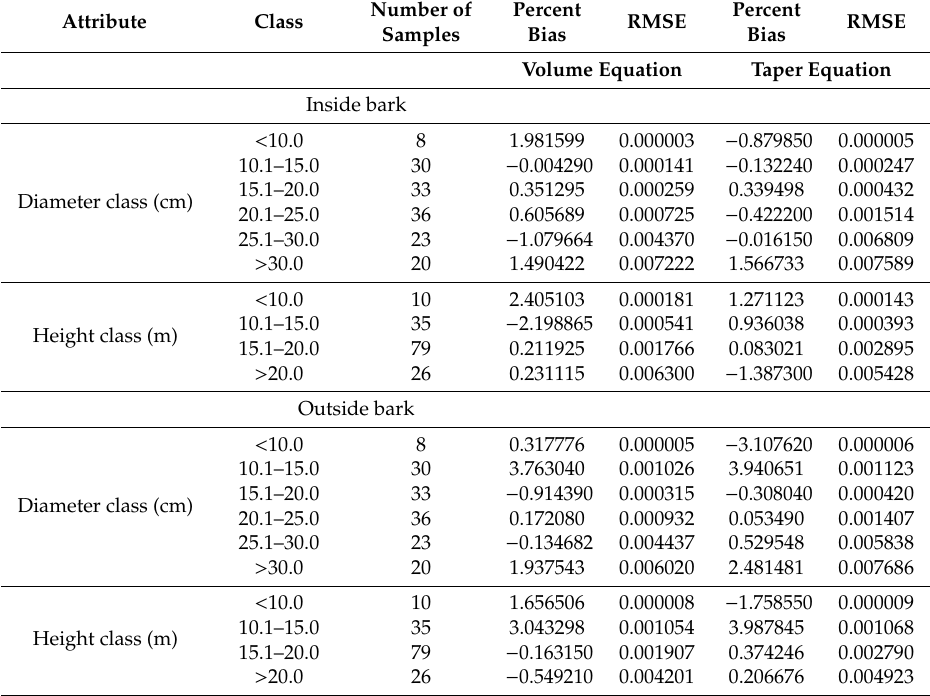
Table 5. Percent bias and root mean square error (RMSE) of the residuals from volume equation (Equation (5)) and taper equation with stand density [6] for red pine plantations grown in Ontario,